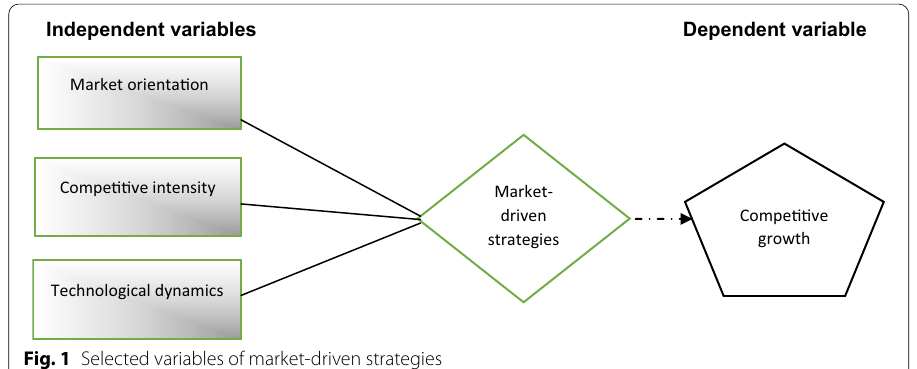
Fig. 1 Selected variables of market-driven